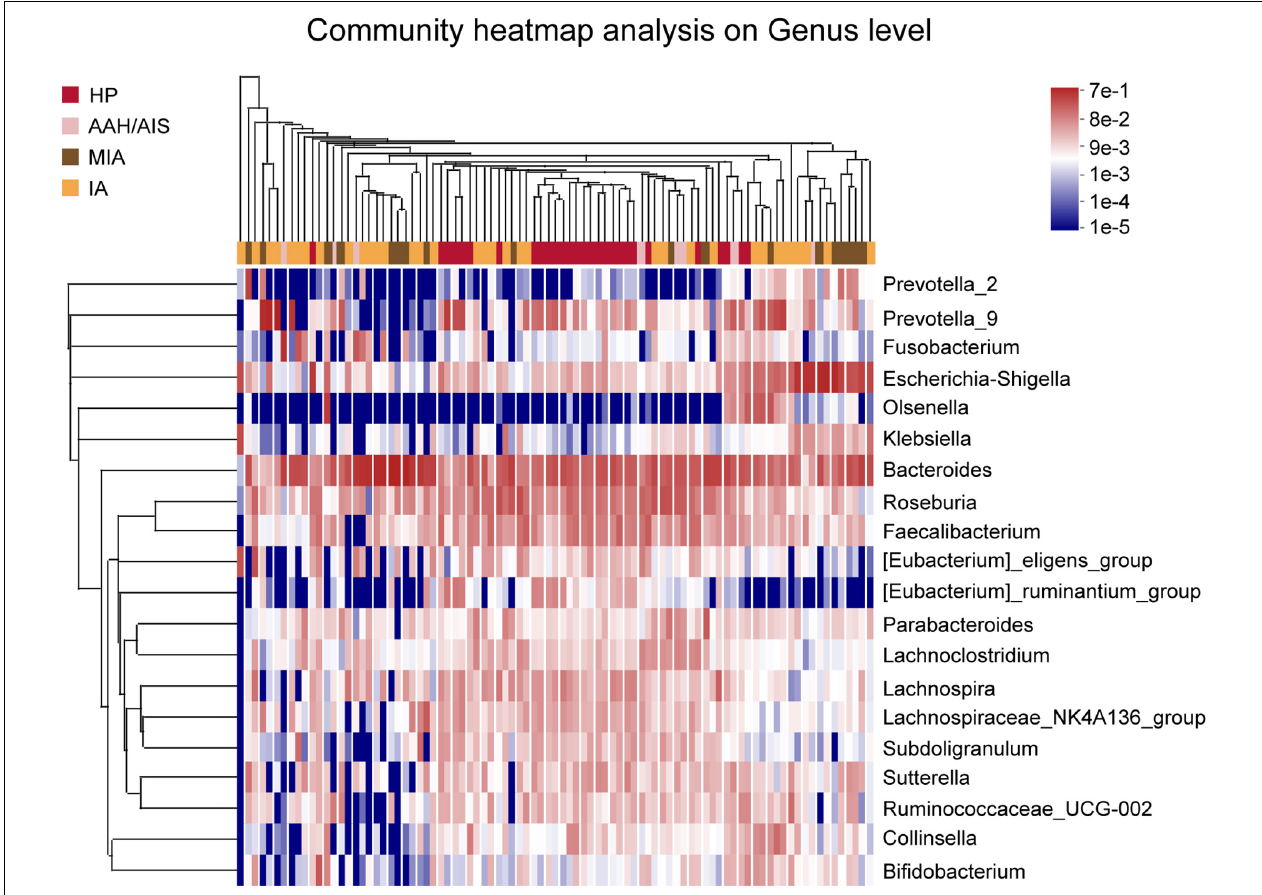
FIGURE 5 | Species classification heat map analysis. The color gradient from blue to red indicates that the distance between the samples is from near toward